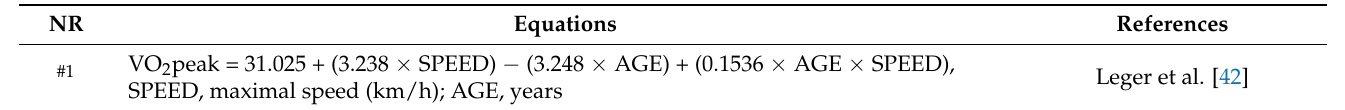
Table 1. VO 2 peak predictive equations used with data from children and youth performing the